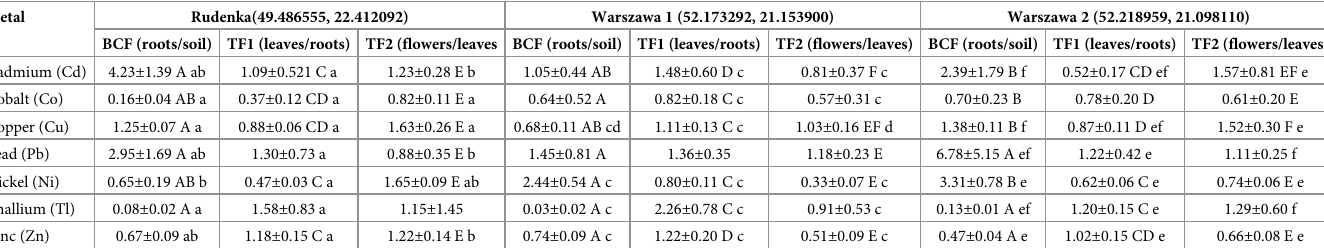
Table 2. Cumulation of heavy metals absorbed from soil by Taraxacum officinale roots and translocation to leaves and flowers.